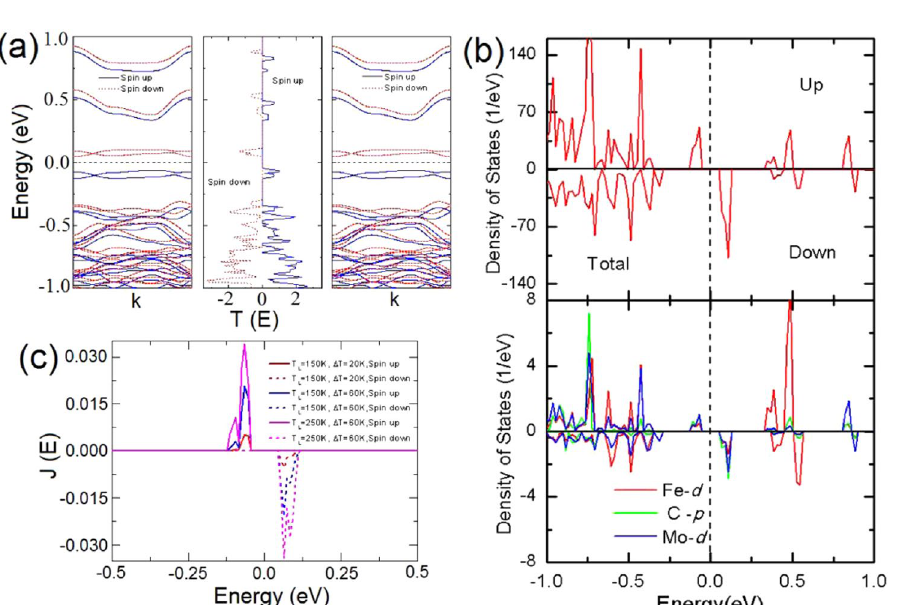
Figure 4. The spin-resolved electronic structures and the current spectra. ( a ) Band structures of electrode (the left panel is the same as the right one) and the spin-polarized transmission spectrum for P (middle panel) spin configuration. ( b ) The electronic structures for Fe-C 6 device and atomic orbital. ( c ) Spin-polarized current spectra for various T L and ∆ T